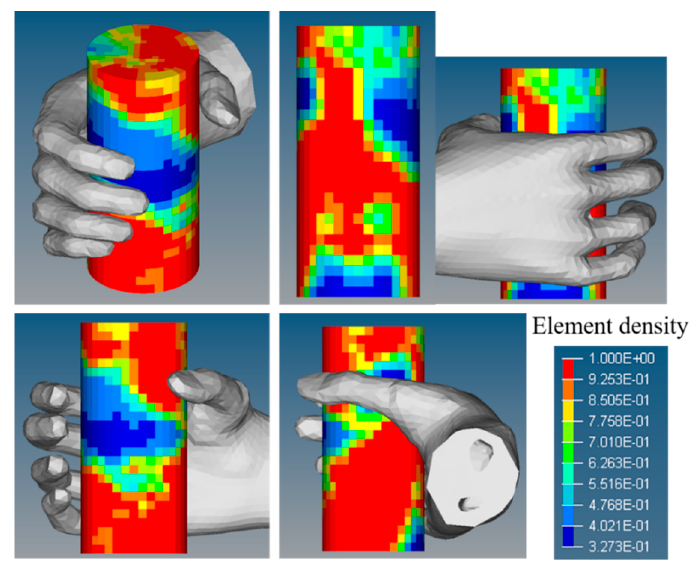
Figure 14. Element density ( − ) distribution of the column FE model after the 7th iteration. Red color denotes high element density and the blue–black color denotes low element density. The hand model is in the initial posture.